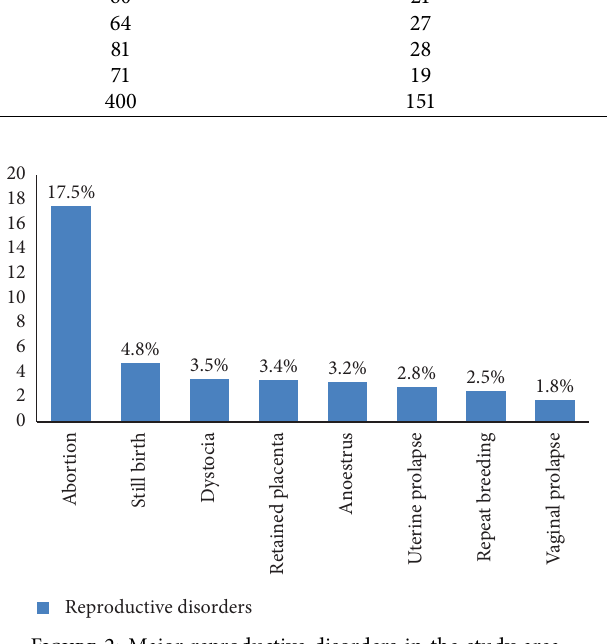
Figure 2: Major reproductive disorders in the study